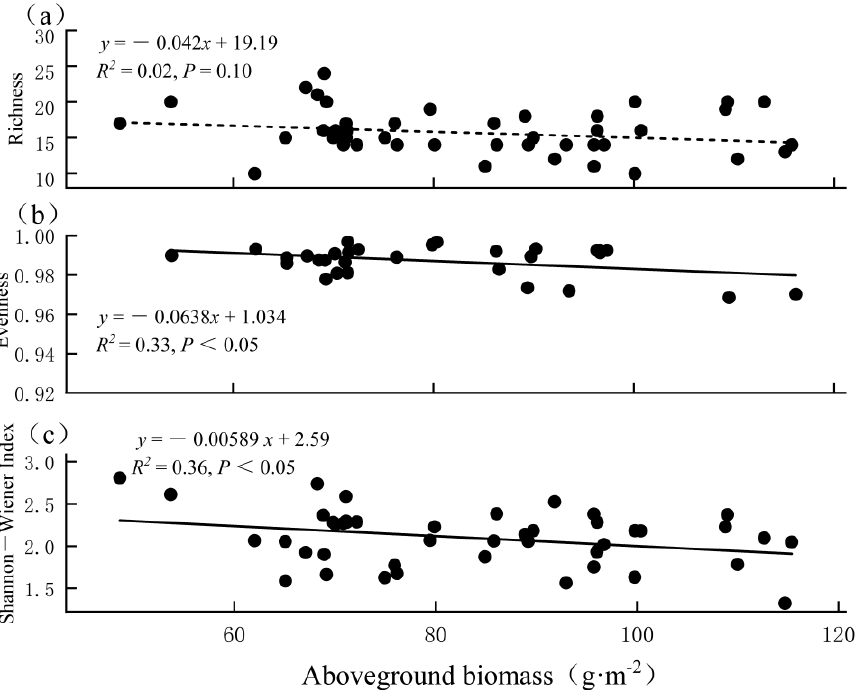
Figure 7. Relationships between aboveground biomass and a) richness, b) evenness, and c) Shan- non−Wiener index across 44 plots in FB. Shannon − Wiener index across 44 plots in